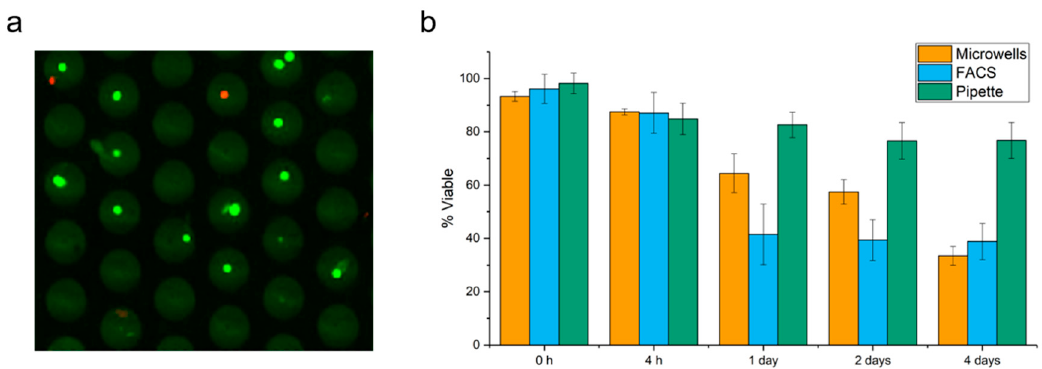
Figure 1. ( a ) Microscopic image of MCF-7 cells seeded into microwells. Live cells, Calc AM positive (green) Ethidium homodimer-1 (EthD1) negative or dead cells EthD1 positive (red), Calc AM negative. (b ) Viability of single cells obtained by self-sorting microwells, fluorescent activated cells sorting (FACS) and pipette.